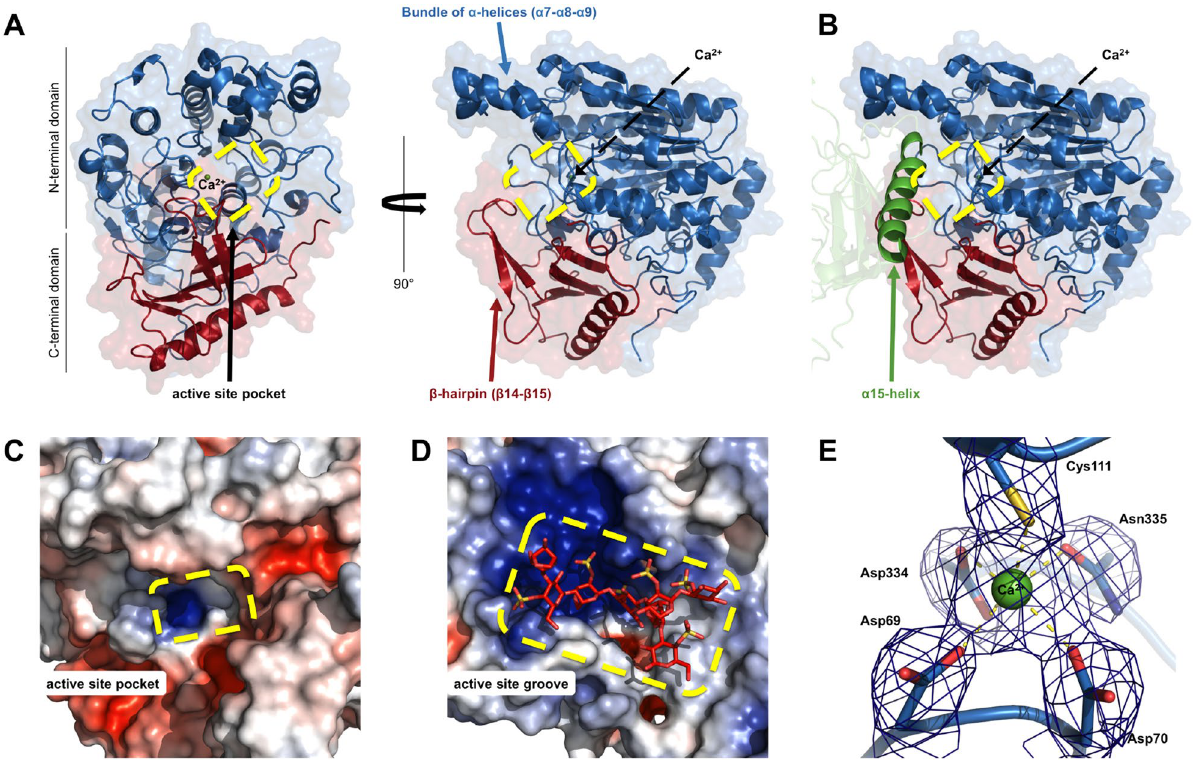
Figure 2. PsFucS1 active site topology. ( A , B ) Cartoon representation of PsFucS1. The N-terminal domain and the C-terminal domain are colored in blue and red, respectively. The active site pocket is circled in yellow. Structural elements delineating the protein active site are indicated by arrows. In ( B ) Part of the interfacing neighboring monomer is indicated in green including the α15 helix that partially covers the active site. ( C ) PsFucS1 crystal structure in electrostatic representation. The active site pocket is circled in yellow. ( D ) Electrostatic representation of the endo-4S-ι-carrageenan sulfatase from Pseudoalteromonas sp. PS47 (6B0J) in complex with κ-ι-κ-neocarrahexaose shown for comparison 18 . The active site groove is circled in yellow. Electrostatic potential is expressed as a spectrum ranging from − 5 kT e −1 (red) to + 5 kT e −1 (blue) and was calculated in APBS 77 . ( E ) Electron density around the calcium ion of PsFucS1. The map shown is a σA-weighted 2mFo-DFc map contoured at 1.2σ (0.67e − Å −3 ). Asp69, Asp70, Cys111, Asp334 and Asn335 residues are shown as sticks. The calcium atom is shown as a green